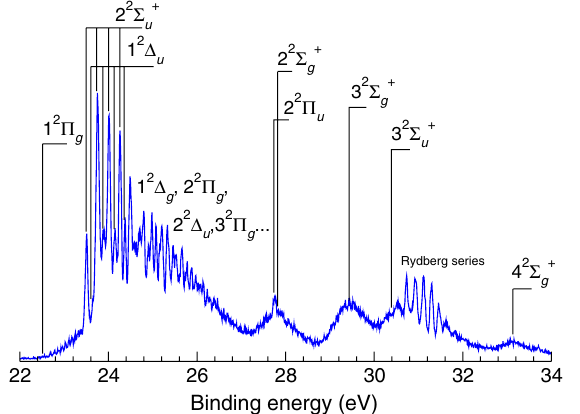
FIG. 3. Experimental resonant Auger spectra with x-ray pho- ton energy tuned to the (cid:3) ¼ 0 vibrational resonance of the N 1 s ! (cid:1) (cid:1) core-excited electronic state (see Fig. 1). The assign- ment is made using the original ab initio calculations and some previous photoelectron studies; see Refs. [10,16,18,20].